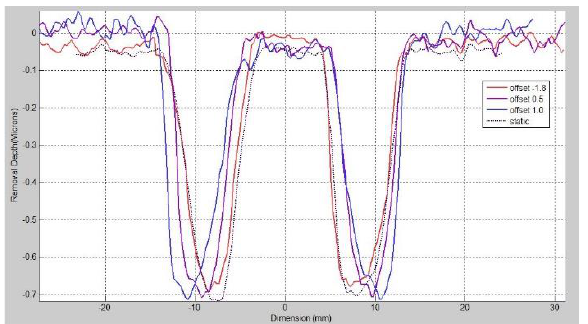
Fig. 4. Dynamic FPs with different tilt angle offsets showing shape change and compensated dynamic FP with static FP (dotted